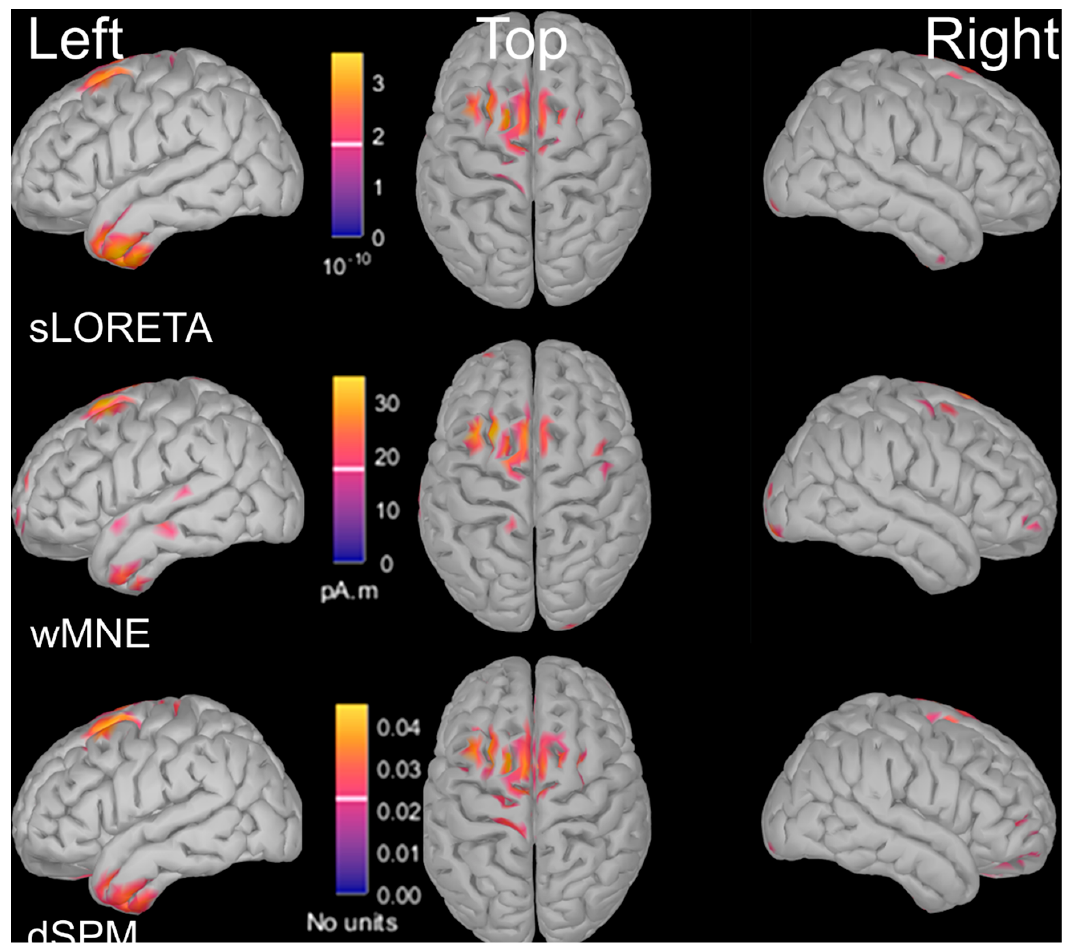
Figure 2. Source localization of EEG signal (4–30 Hz) during gait initiation in a paradigm using cues and flankers (task described in [16]). The signal was averaged over a time interval between 200 and 0 ms before the onset of the anticipatory postural adjustments. Three different methods for source localization were applied on the same EEG dataset (128 electrodes). All three methods showed sources in premotor cortex, supplementary motor area and primary motor cortex. Only sLORETA and dSPM showed sources on left temporal lobe but not wMNE.